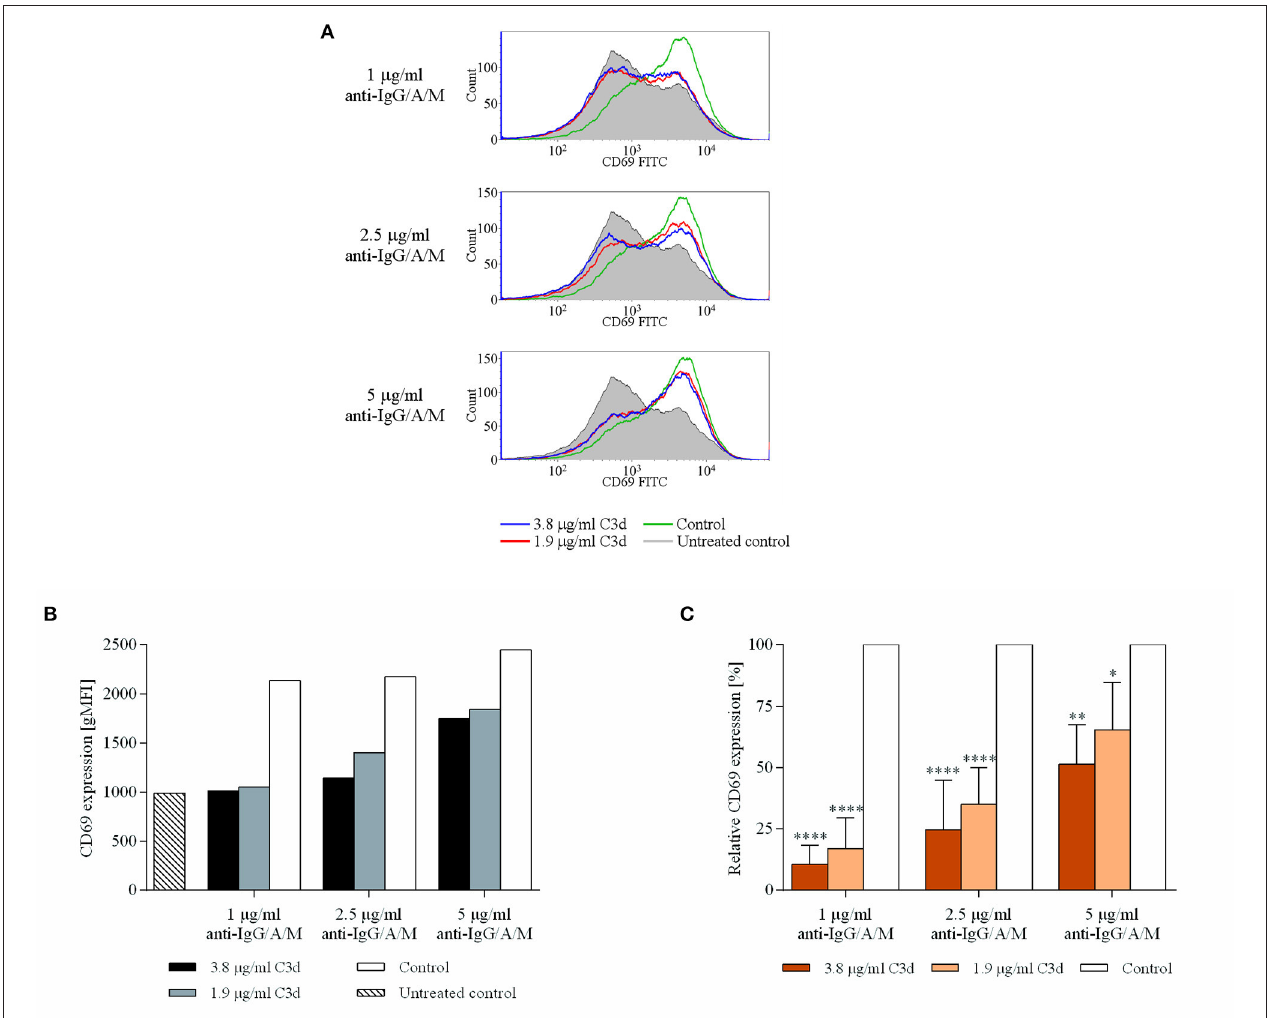
FIGURE 2 | C3d inhibits the BCR-induced expression of CD69 activation marker, on human B cells. Resting human B cells were cultured with complexes consisting of either streptavidin-conjugated biotinylated anti-IgG/A/M (control) or streptavidin-linked biotinylated anti-IgG/A/M and biotinylated C3d in different concentrations as indicated. The expression of CD69 was measured by flow cytometry after 24h. Histograms (A) and gMFI values (B) of a representative experiment are shown. Mean gMFI values of distinctly treated samples were compared to the control samples taken as 100%, and the cumulative results gained in three independent experiments display the mean of the relative values ± SD (C) . * p < 0.05, ** p < 0.01, **** p <